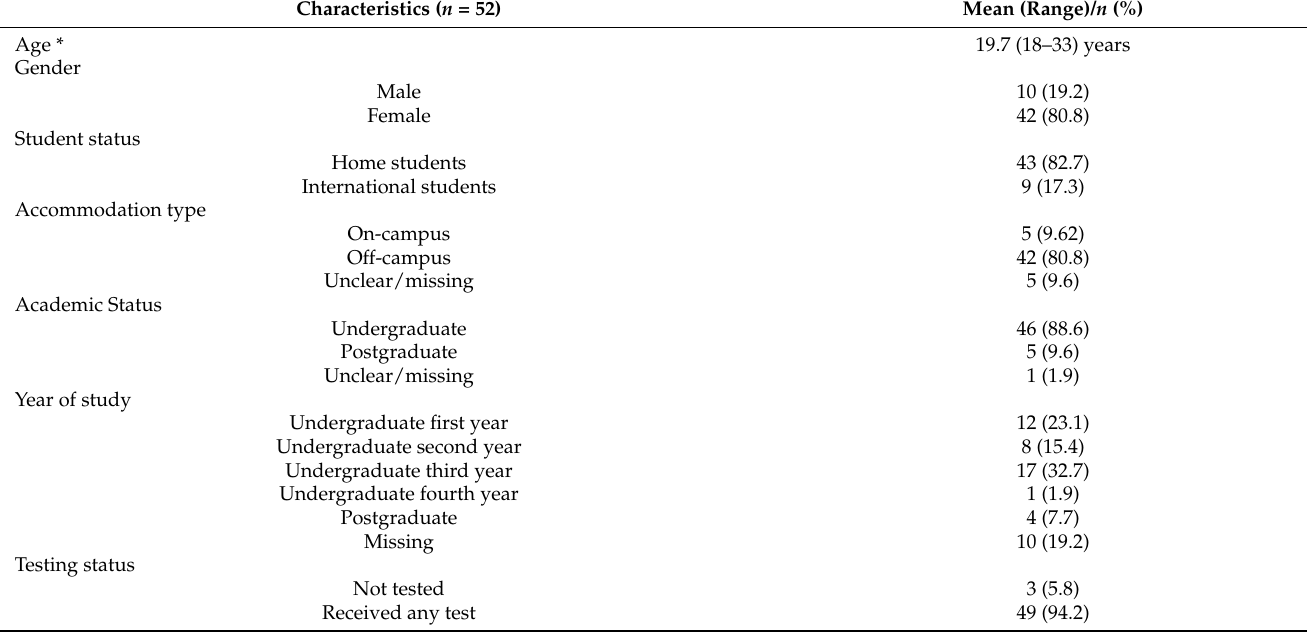
Table 1. Sample characteristics of